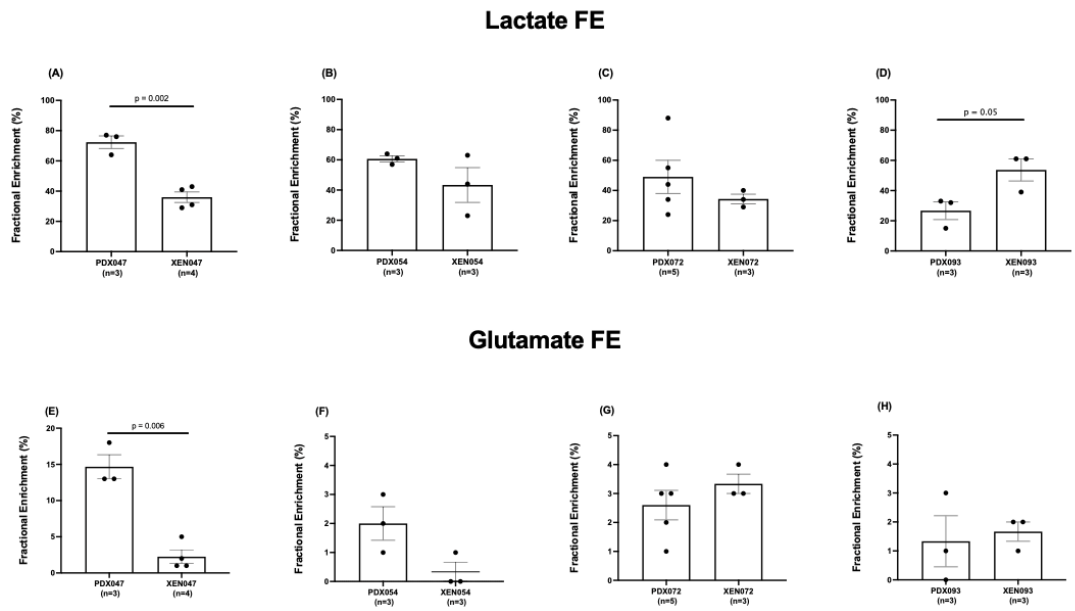
Figure 8. Comparison of fractional enrichment of ( A ) lactate and ( B ) glutamate among PDX.